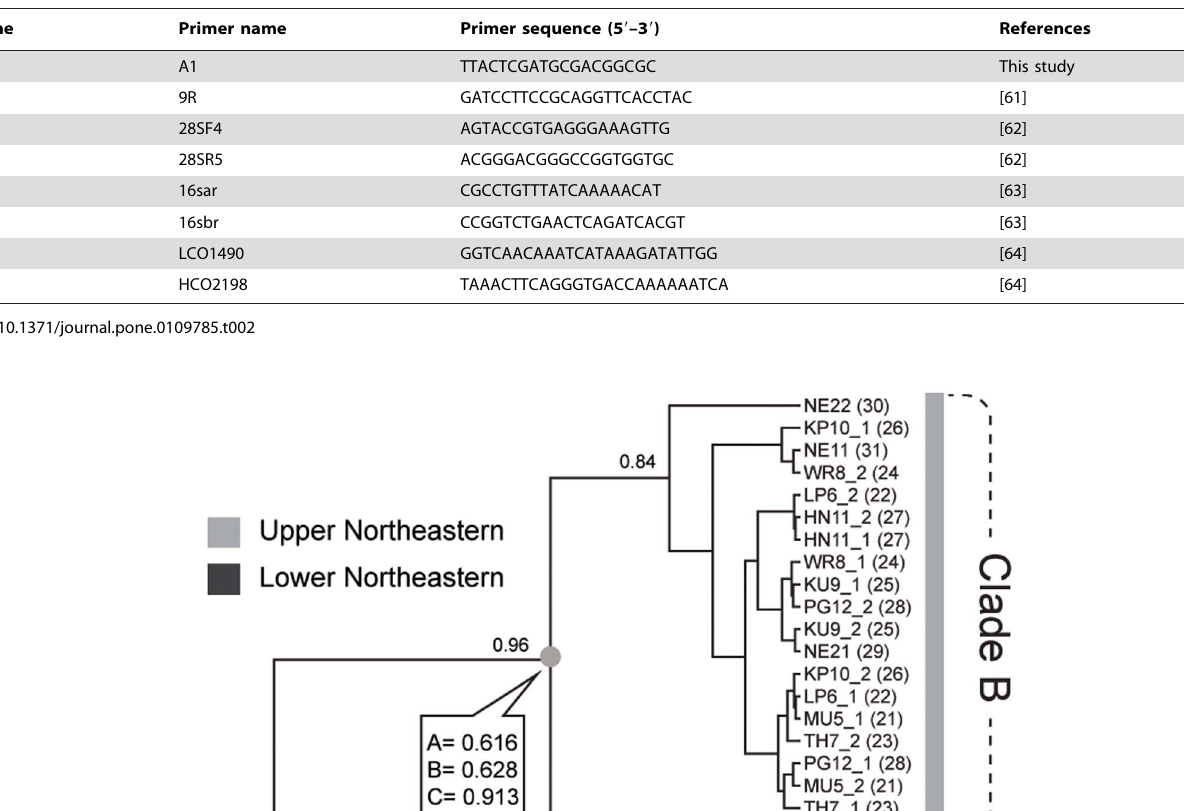
Table 2. List of primers used in this study.